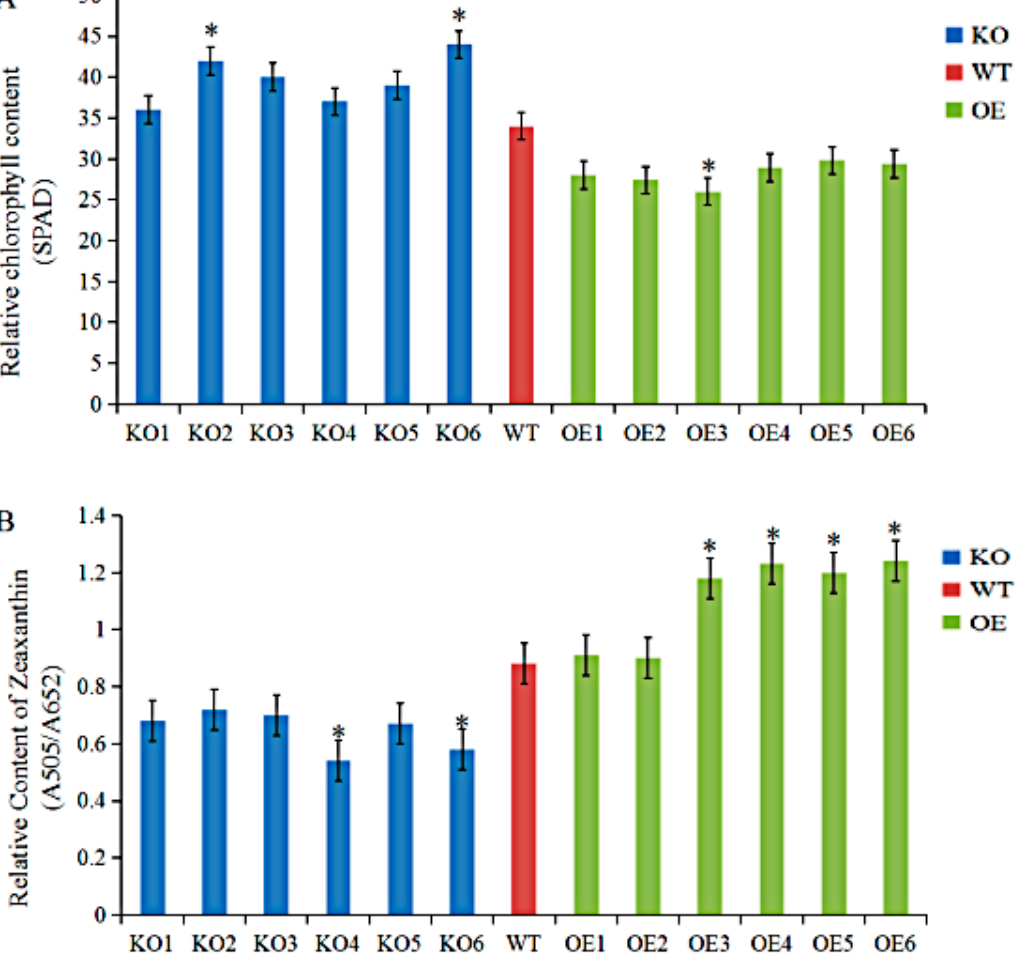
Figure 5. Non-photochemical quenching (NPQ)-related physiological indicators of WT and the T 2 generation of GmRIQ2 - like- OE and -KO transgenic one-month seedlings. ( A ) SPAD (soil-plant analyses development) values of WT and GmRIQ2 - like -OE transgenic soybean seedlings were detected using a SPAD-502 Chl meter to obtain the relative contents of Chl. ( B ) The relative zeaxanthin contents of WT, GmRIQ2 - like -OE, and -KO transgenic soybean seedlings were detected using a spectrophotometer at 505 and 652 nm. Vertical bars represent the SE ( n = 3; each treatment consisted of 30 seedlings). Asterisks indicate significant differences (* p < 0.05) between the transgenic lines and WT.